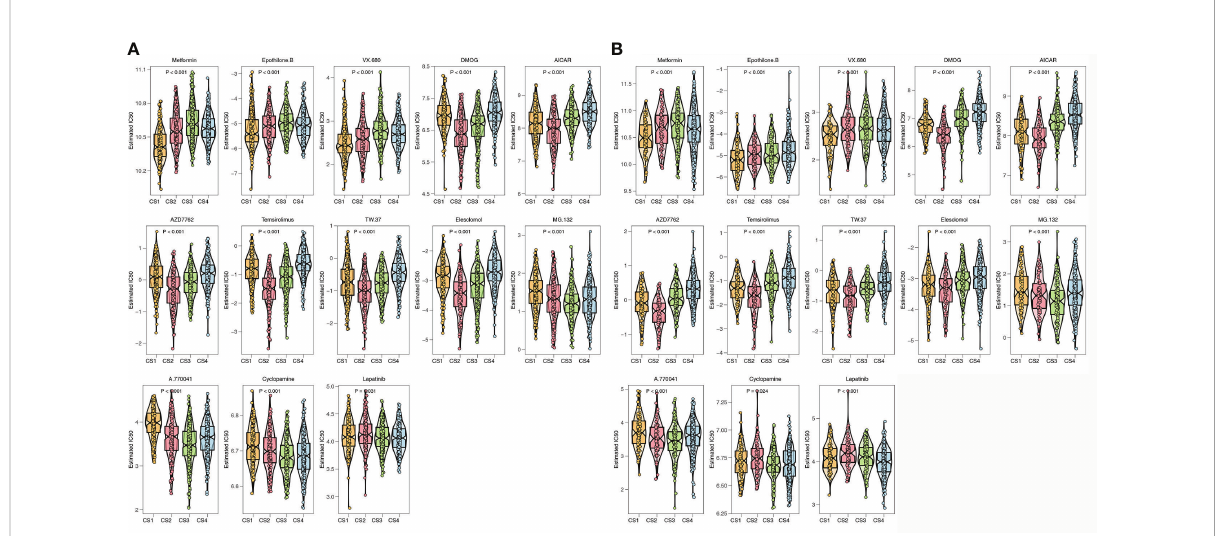
FIGURE 8 Prediction of chemotherapeutic sensibility. (A) Prediction of chemotherapeutic sensibility for the TCGA. (B) Prediction of chemotherapeutic sensibility for the GEO.